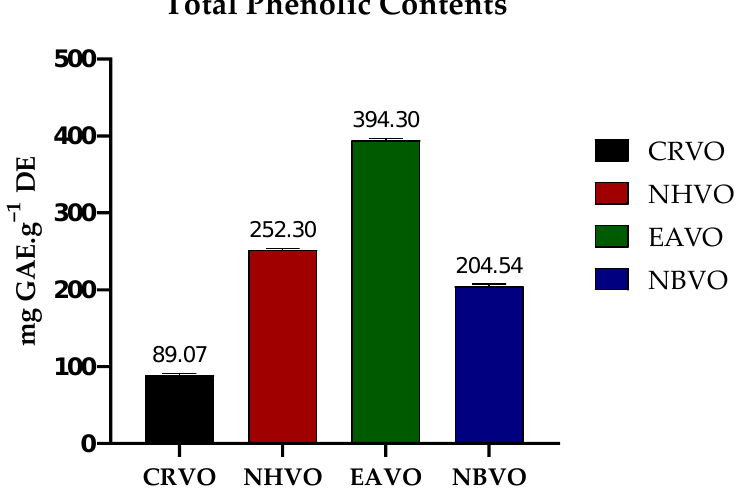
Figure 1. Total phenolic content (TPC) of the whole plant of Verbena officinalis fractions (All experi- ments were performed in triplicates and the error bar represents standard deviation). CRVO; crude methanol fraction, NHVO; n -hexane fraction, EAVO; ethyl acetate fraction, NBVO; n -butanol fraction, GAE; gallic acid equivalent and DE; dry extract.